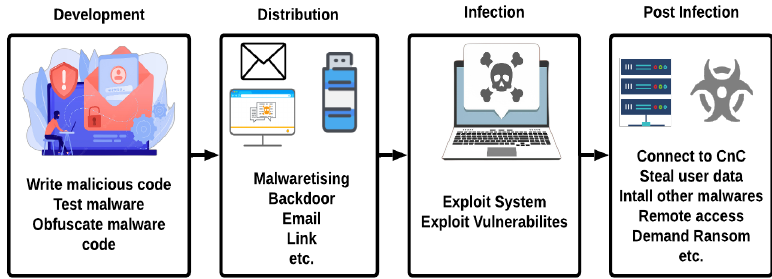
Figure 2. Life cycle of file-based